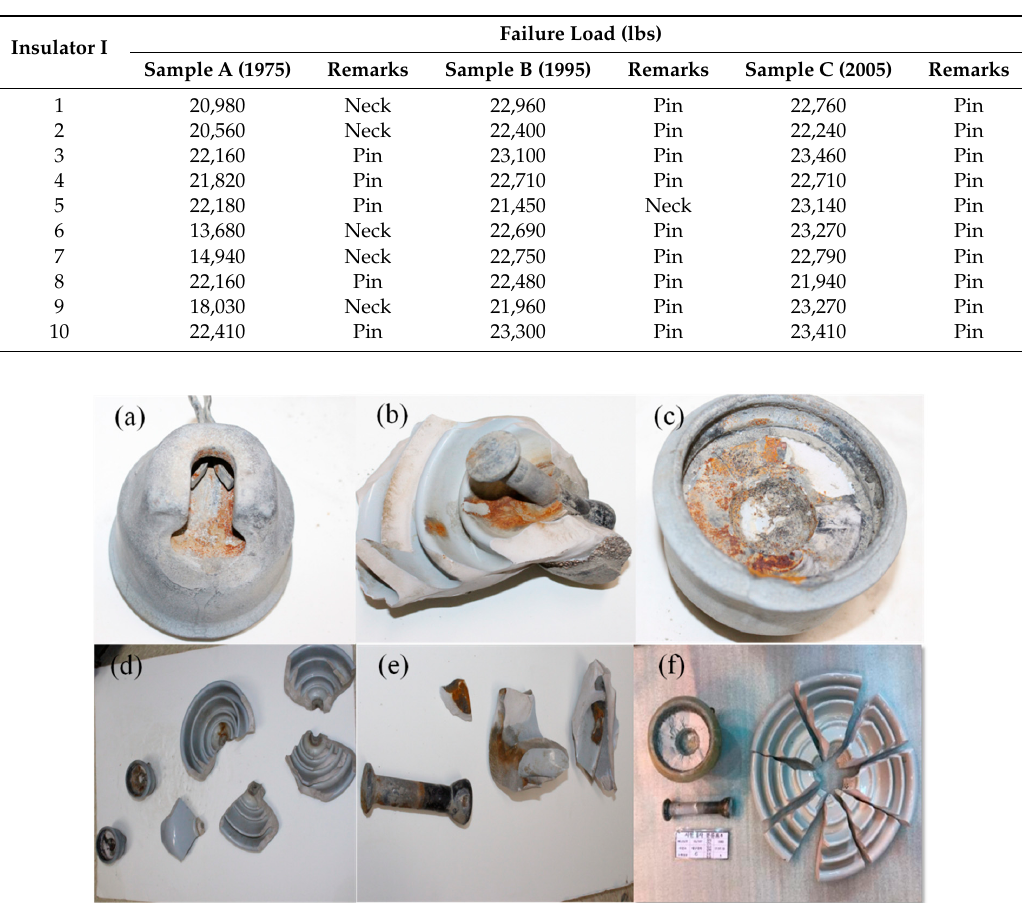
Figure 1. Mechanical and electrical failure of insulators that failed the load tests: ( a ) separated cap, ( b ) broken insulator, ( c ) cap separated, ( d ) broken insulator, ( e ) pin pulled out and mechanical failure, and ( f ) break due to electrical failure. Table 1. Details of mechanical load tests with electrical voltage (M&E) test results.